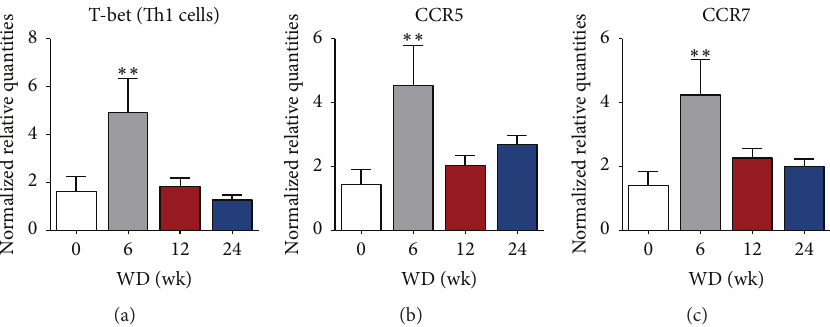
Figure 3: Features of inflammation in mouse aortic plaques. ((a), (b), (c)) Relative mRNA levels of T-bet (a), CCR5 (b), and CCR7 (c) in plaque-containing aortic tissue measured by real-time qPCR. 0 wk, 𝑛 = 6 , 6wk, 𝑛 = 5 , 12wk, 𝑛 = 11 , and 24 wk, 𝑛 = 14 - 15 ; ∗ 𝑃 < 0.05 and ∗∗ 𝑃 < 0.01